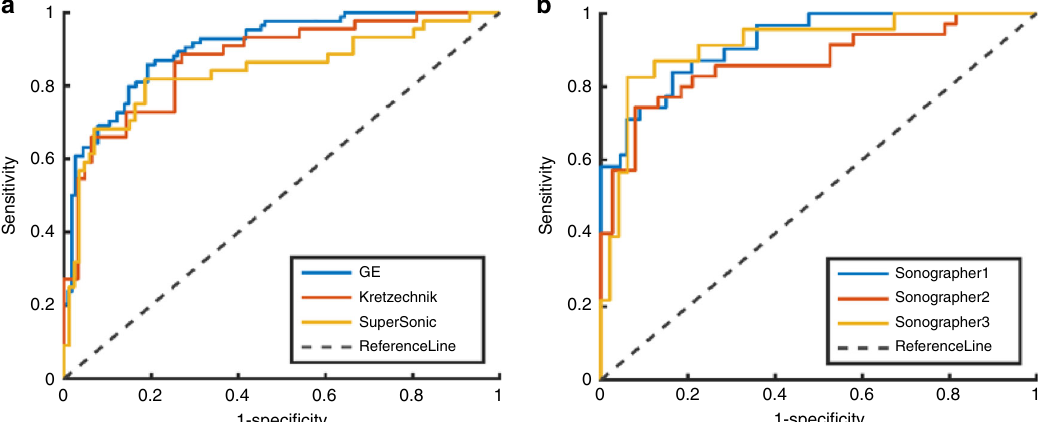
Fig. 2 Comparison of ROC curves when data from different machines and different doctors are used as independent test sets. a shows ROC curves when data from different machines, b from different doctors.